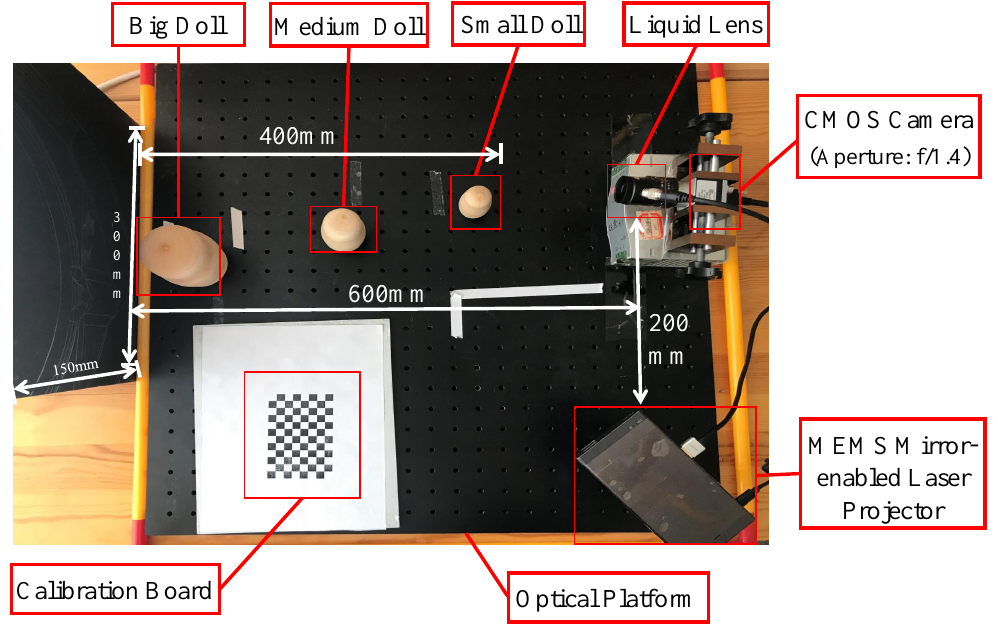
Figure 4. The prototype system and the test scene. The system includes a MEMS mirror-enabled laser projector, a CMOS camera equipped with a liquid lens, and a control platform for synchronization. Three different sizes of dolls are placed in front of the camera, from far to near. The specific scene is shown in the